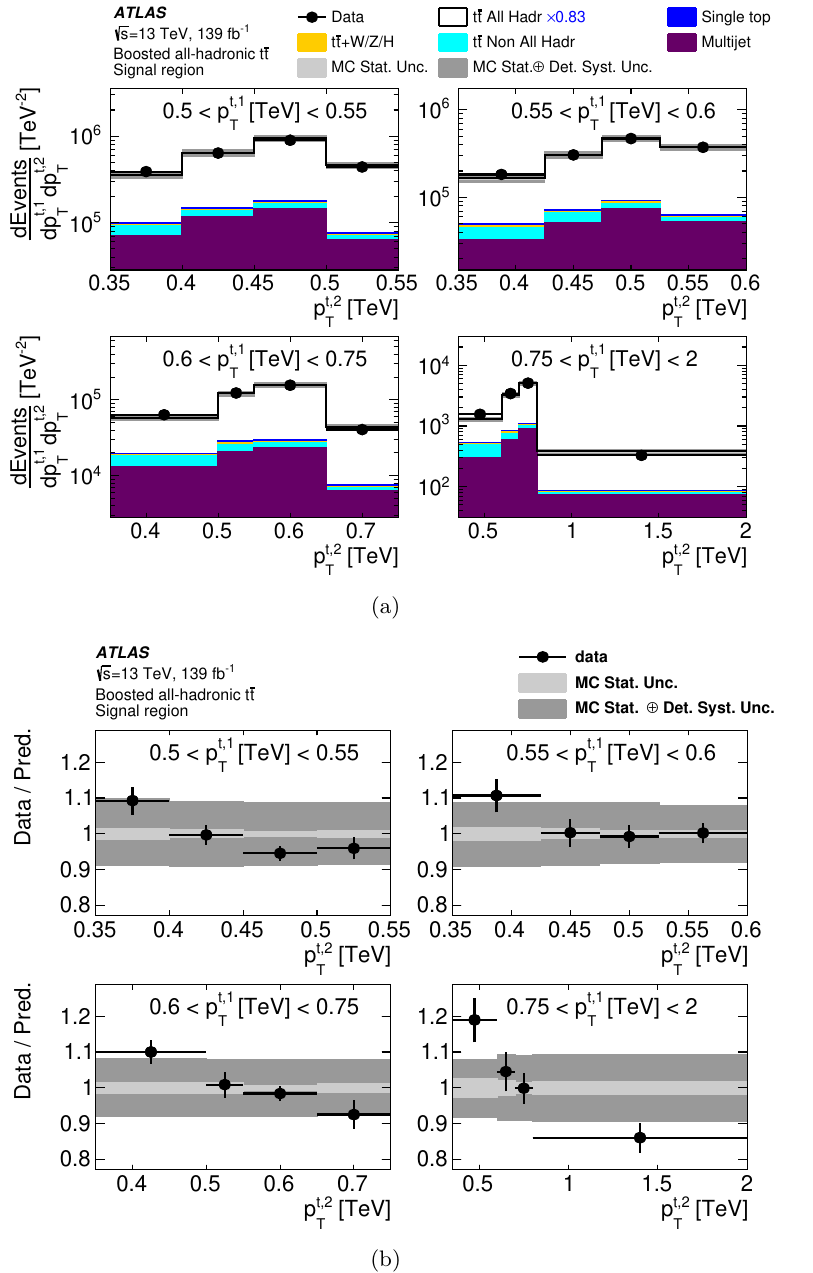
Figure 5 . Two-dimensional kinematic distributions of second-leading jet p T versus leading-jet p T in the signal region: (a) the differential event yield as a function of the p T of the leading jet and p T of second-leading jet, and (b) the ratio of the observed and predicted distributions. The signal prediction (open histogram) is based on the Powheg + Pythia 8 t ¯ t calculation normalized to the observed yield. The background (solid histogram) is the sum of the data-driven multijet estimate and the MC-based expectation for the contributions of non-all-hadronic t ¯ t , single-top-quark, and t ¯ t + W/Z/H processes. The light grey bands indicate the statistical uncertainties and the dark grey bands indicate the combined statistical and detector-related systematic uncertainties defined in section